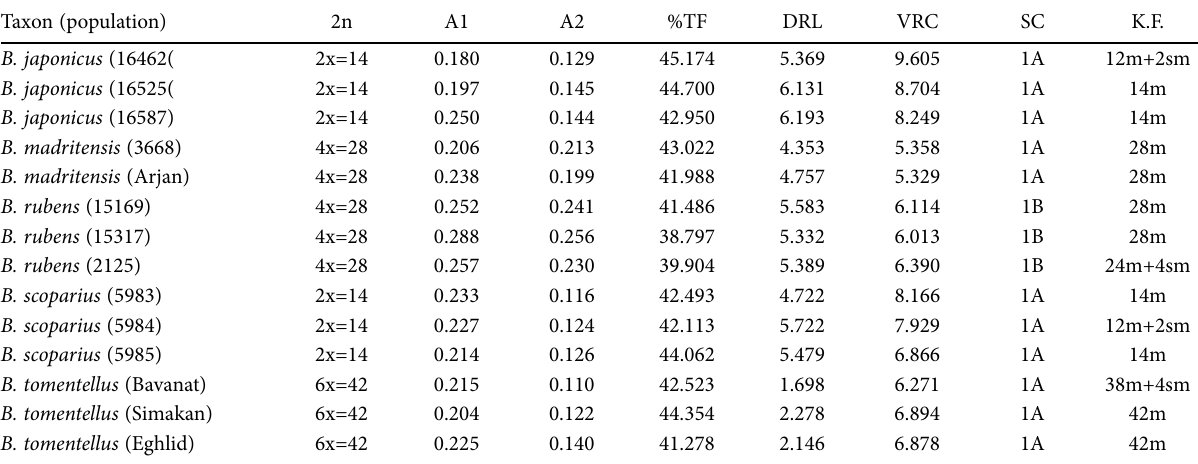
Table 2. Karyotypic characters of different Bromus taxa and population. Taxon